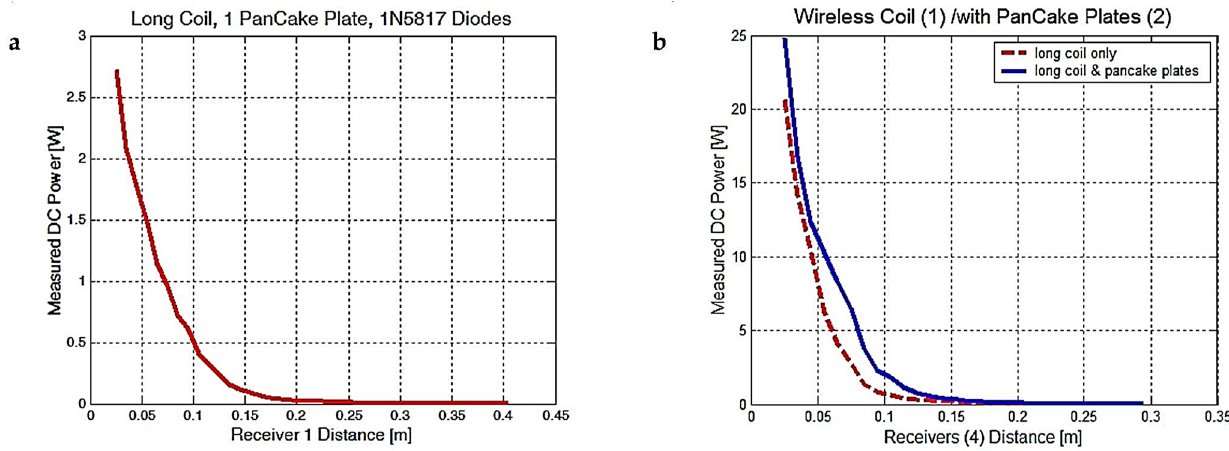
Figure 8. ( a ) Measured DC power for the C1 configuration, one long RF coil, one flat pancake coil as the transmitter and one pancake plate as the transducer. ( b ) Measured DC power for four transducers in the C2 and C3 wireless configurations, (C2 configuration) a long RF coil as the transmitter and (C3 configuration) both an RF coil and two pancake plates as the transmitters.